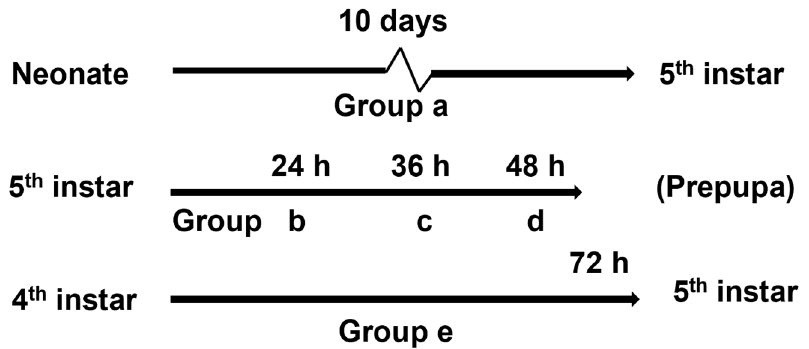
Figure 1. The five exposure protocols to assess habituation of H. armigera and H. assulta upon exposure to the deterrent alkaloid strychnine tested in this study.